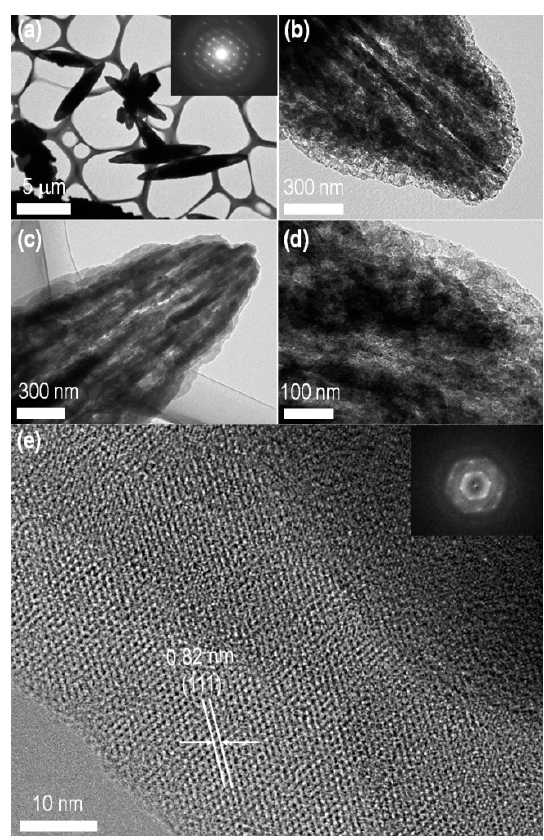
Figure 2. Transmission microscopic images of C 60 crystals prepared a liquid-liquid interface of IPA and C 60 solution in dodecylbenzene at 25 °C: ( a – d ) Low magnification TEM images; ( e ) HR-TEM image. Insets of panel “a” and “e” represent SAED patterns. Weak diffraction peaks at diffraction angles of 10.14° and 19° (as highlighted by symbol) corresponds to (101) and (401) planes of hcp crystal phase, which is commonly observed in solid solvates due to the entrapment of solvent molecule at the interstitial site of the cubic lattice during crystallization [48,49].